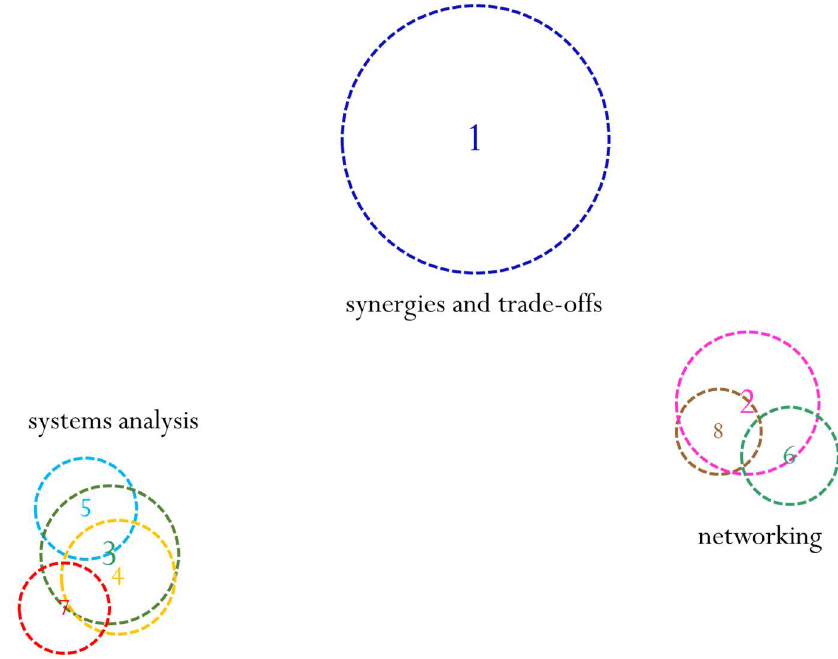
Figure 4. Theme map derived by the Multidimensional Scaling (MDS) technique.